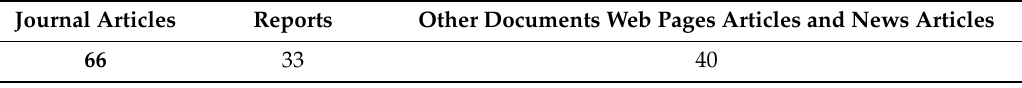
Table 1. Journal articles, reports and news articles that shaped the trajectory of the study. Journal Articles